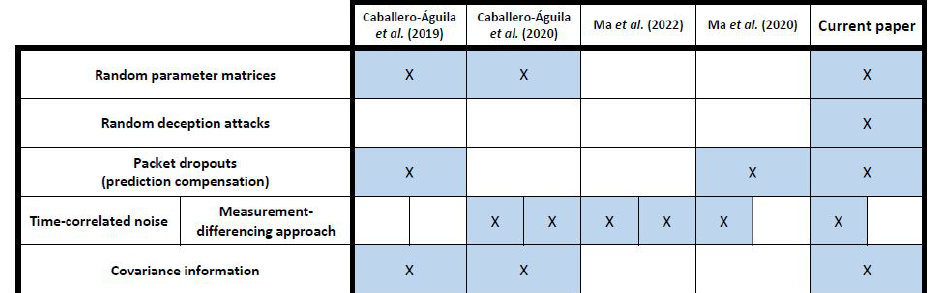
Figure 1. Related work [18,24–26]: comparison with the current